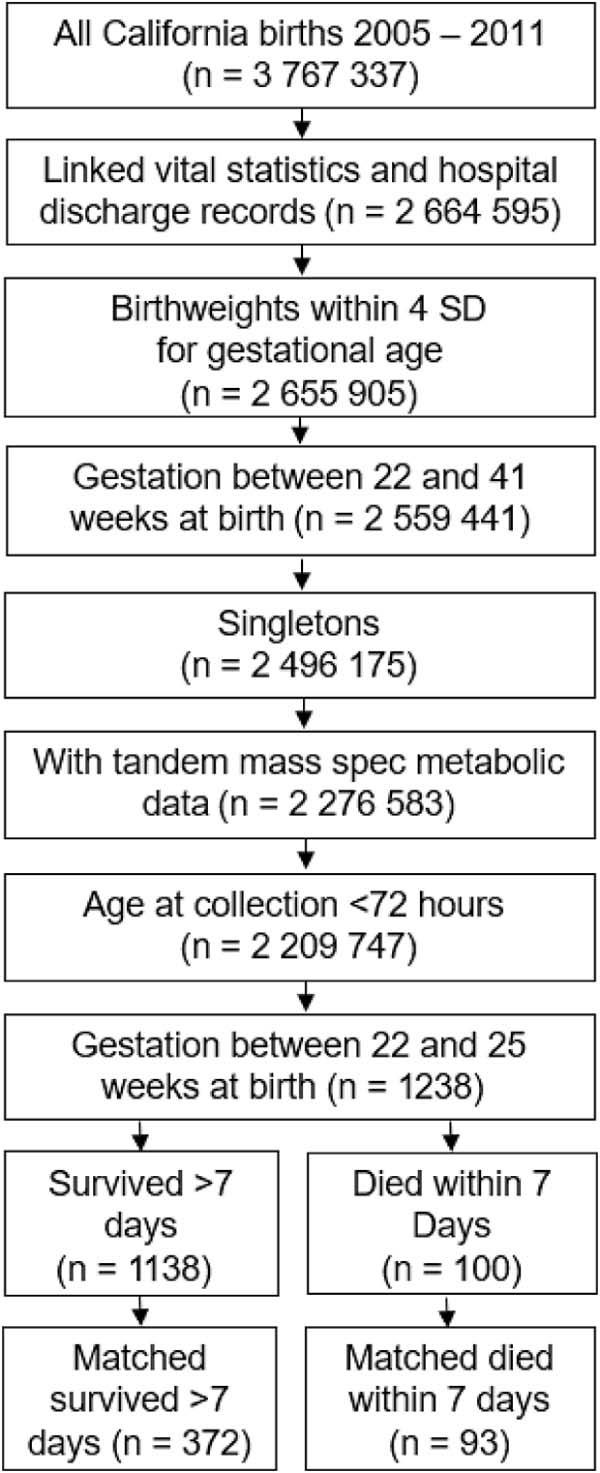
Flow chart of infants born in California between 2005 and 2011 eligible for analysis.